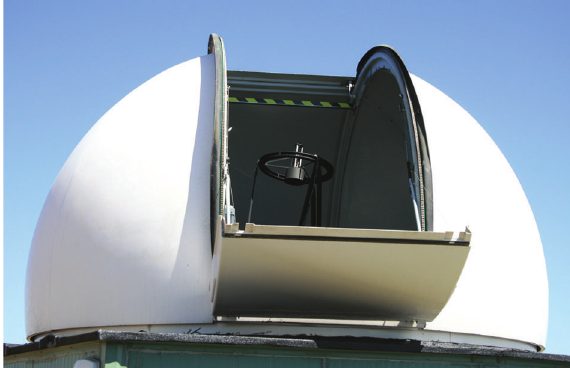
Figure 7: View of the dome for the 0.5 m telescope located in EVA1 El Frasno.